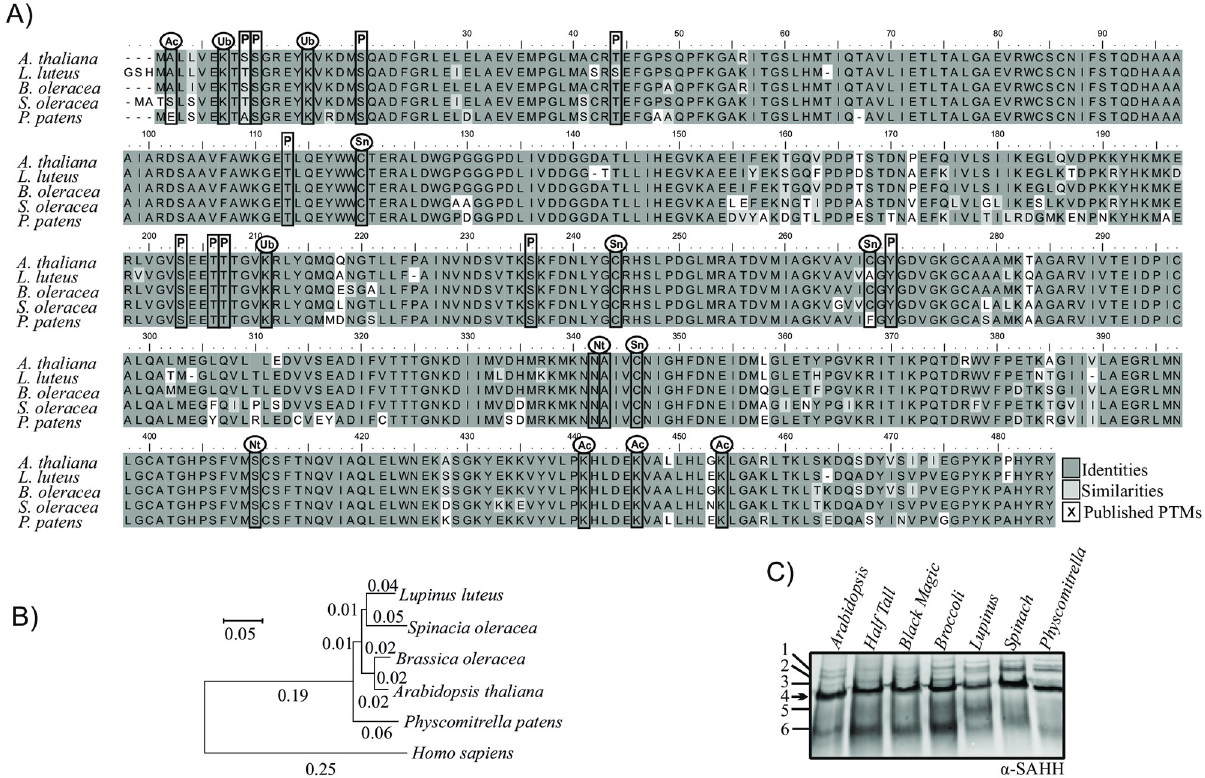
Fig 4. Evolutionary conservation of SAHH on protein level. A) Amino acid sequence alignment of SAHH1 between A . thaliana , L . luteus , B . oleracea , S . oleracea and P . patens . Ac, Lysine Acetylation; P, phosphorylation; Nt, N-terminus Proteolysis; Sn, S-nitrosylation; Ub, ubiquitination. B) Phylogenetic tree based on SAHH1 amino acid sequence constructed using the neighbor-joining method. Numbers represent substitution per amino acid based on data from 500 trees. C) SAHH containing protein complexes in evolutionarily divergent plant species as detected by anti-SAHH antibody. Total soluble protein extracts of A . thaliana , B . oleracea convar italic (broccoli), B . oleracea convar acephala var. Half Tall (kale) and B . oleracea convar acephala Black Magic (kale), L . luteus , S . oleracea and P . patens were separated on CN-PAGE. A . thaliana protein complexes typically detected by anti- SAHH antibody are indicated by numbers. The abundant protein complex detected by anti-SAHH antibody is indicated by arrow.